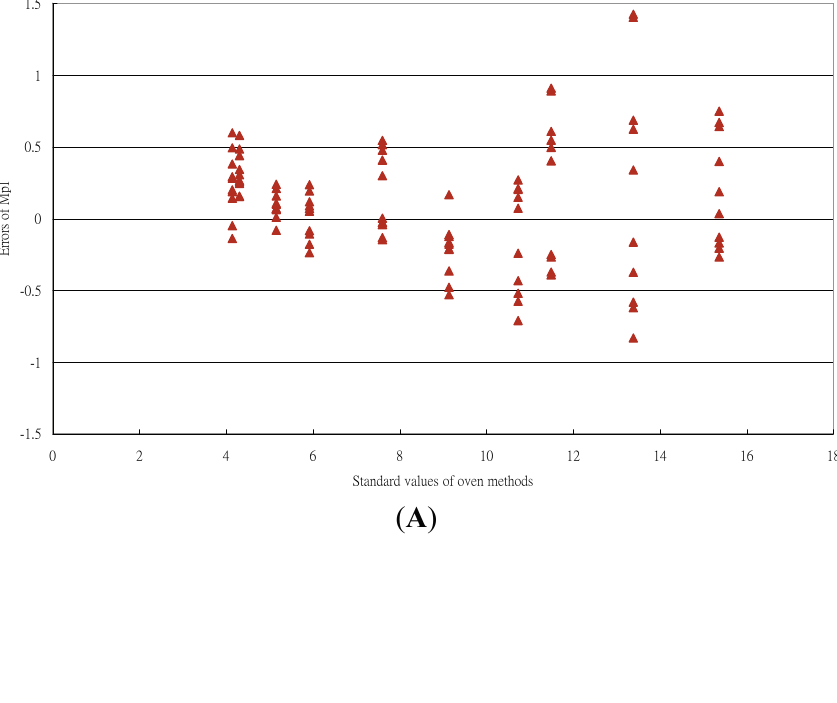
equation; ( C ) the M p2